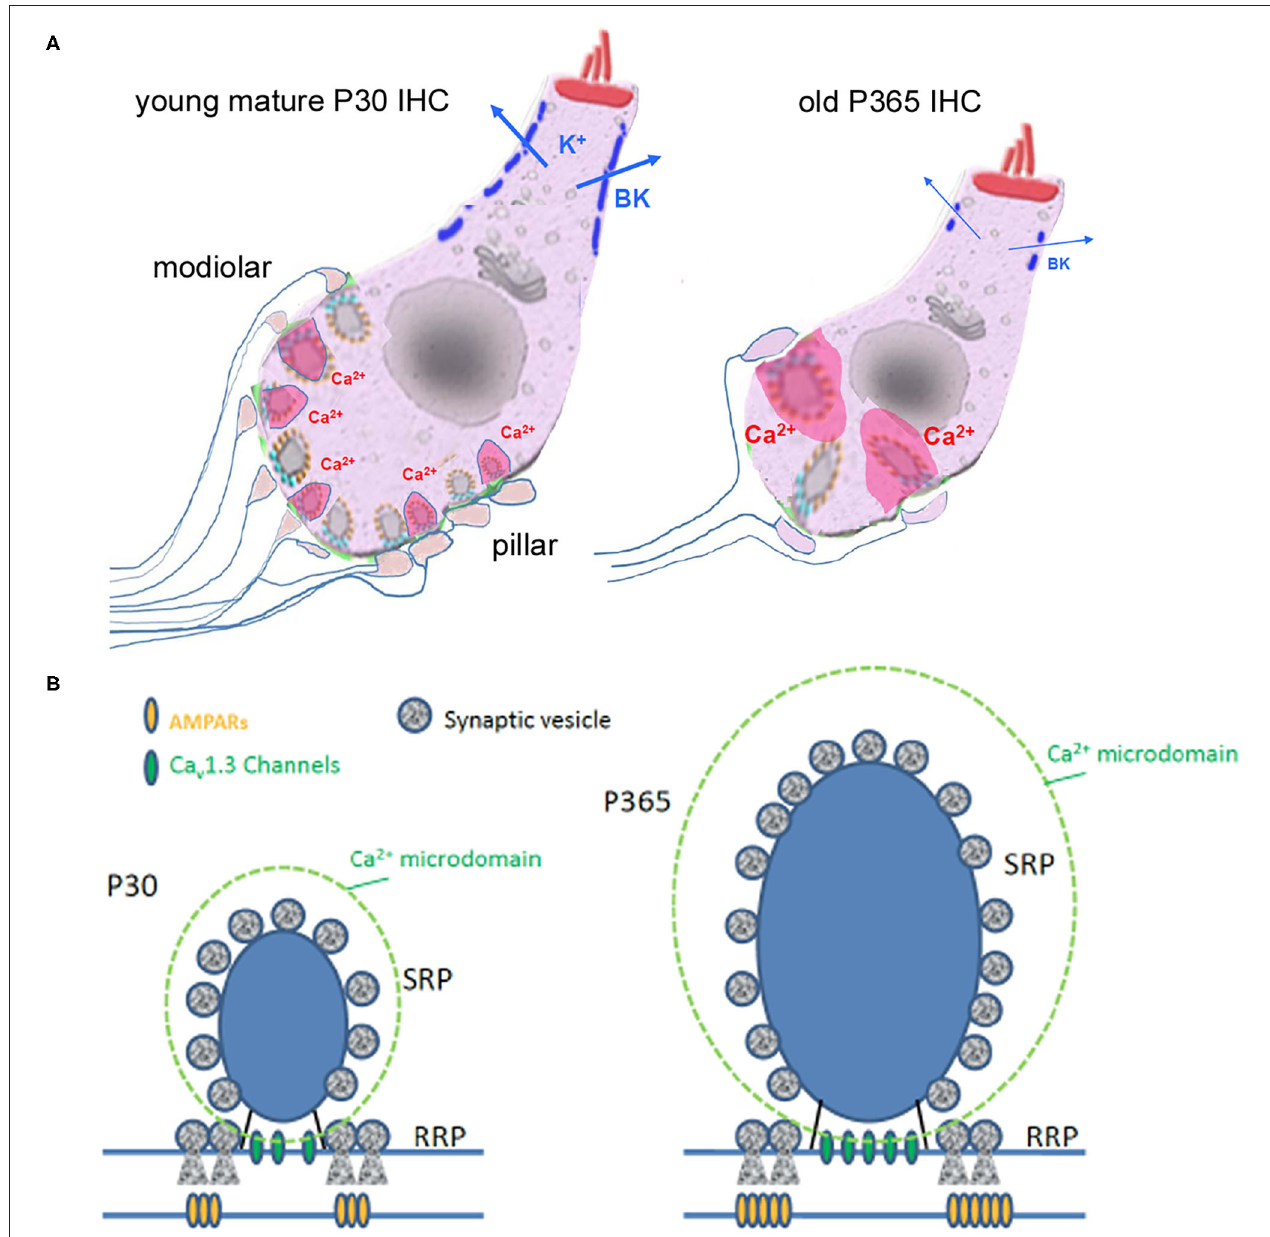
FIGURE 11 | Synaptic IHC degeneration was associated with a strong potentiation of the remaining ribbon synapses in aging C57BL/6J mice. (A) Age-related hearing loss in P360 mice was associated with IHC shrinkage (cell size reduction), an important loss of afferent ribbon synapses ( > 50%), a drastic enlargement of the surviving synaptic ribbons (both at pillar and modiolar side), an increase in Ca 2 + signaling (larger Ca 2 + microdomain amplitude as indicated by the larger pink domains around the ribbons) and a large decrease in the fast-repolarizing BK channel clusters (blue bars). (B) Hypothetical view of a young and old IHC ribbon synapse.